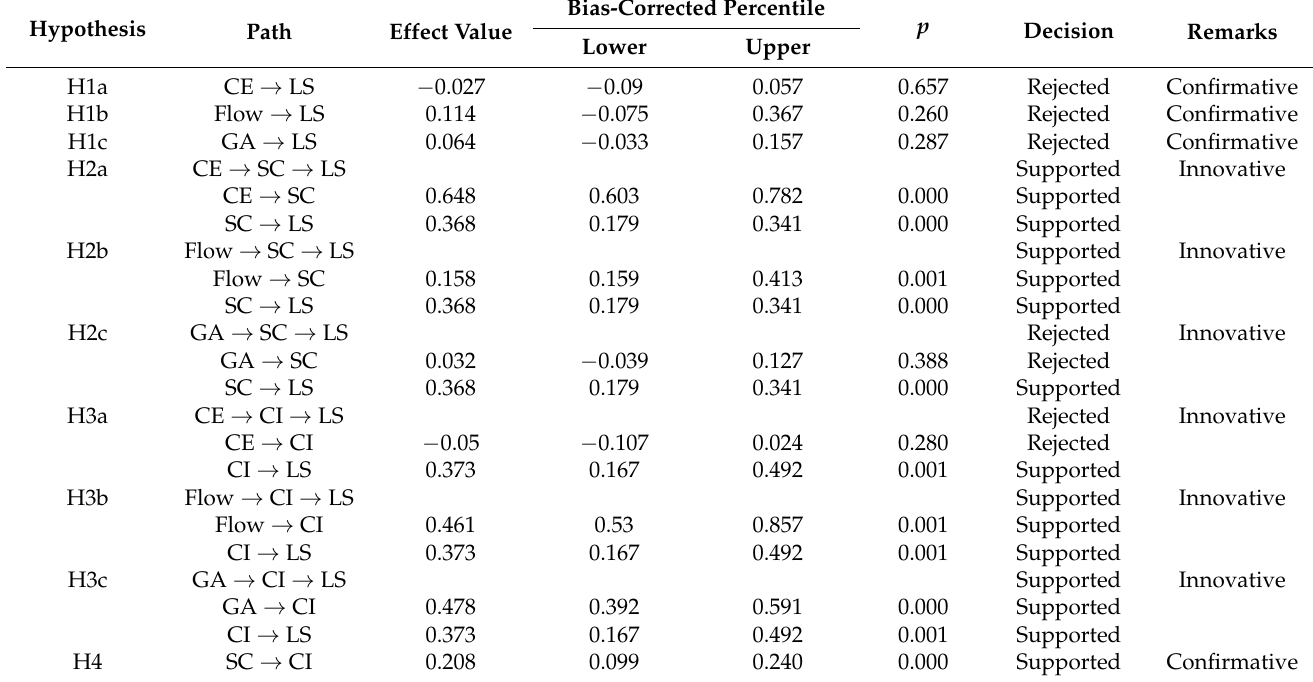
Table 8. The bootstrap test of the mediation model.